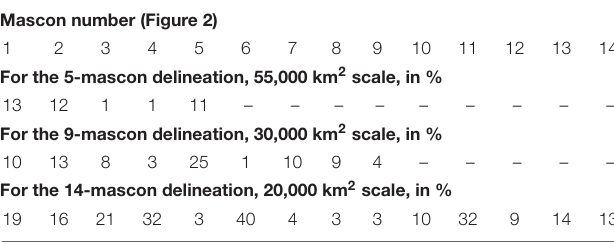
TABLE 6 | Coefficient Of Variation (COV) of the focused masses.